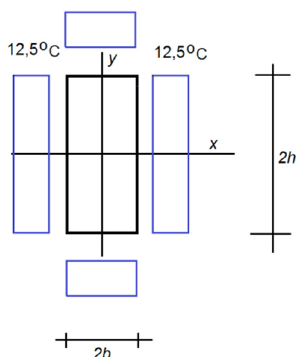
Figure 4. The symmetrical part of the task. SS state.